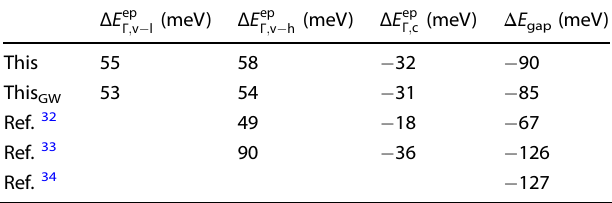
), the v (cid:1) h ) together v (cid:1) l ). DFT effective gap